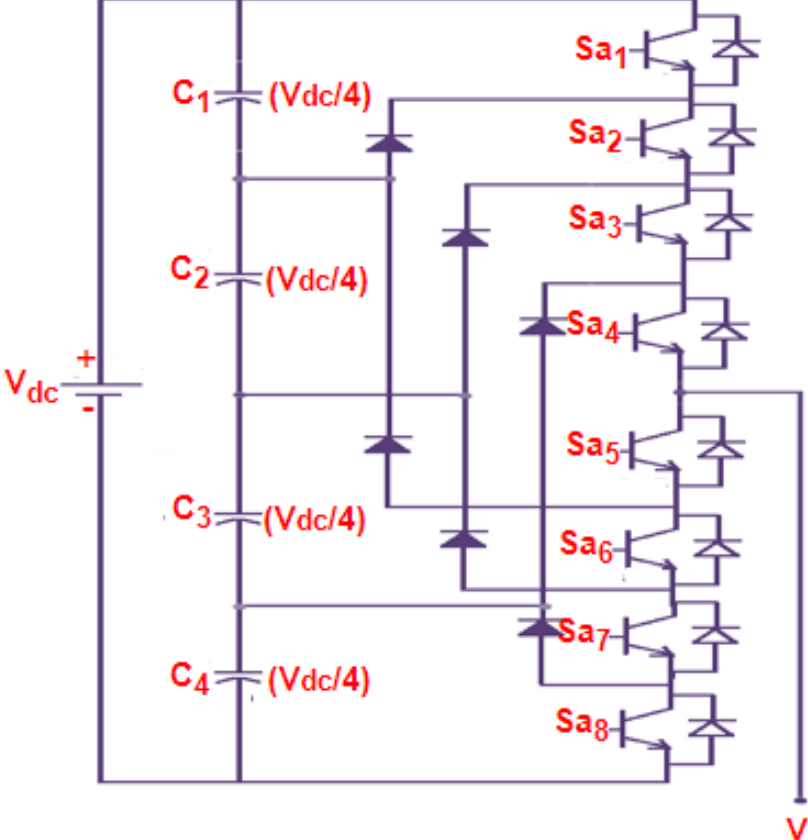
Figure 8. A five-level diode clamped multilevel Figure 8. A five ‐ level diode clamped multilevel inverter. Table 3. Switching positions of NPC ‐ MLI.